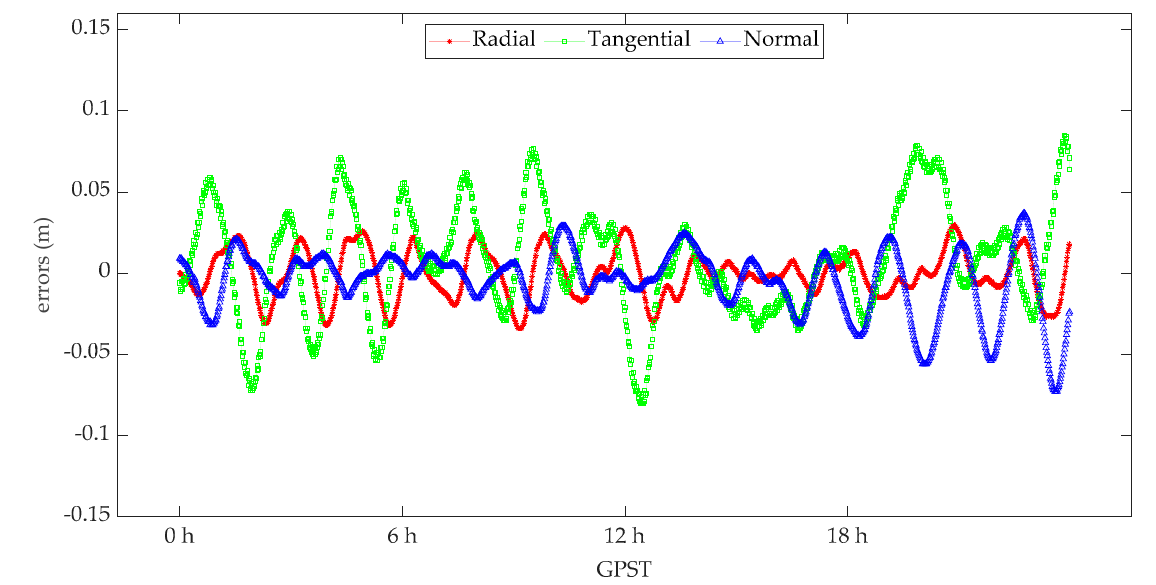
Figure 7. The variation in errors for the HY2D satellite using spaceborne GPS data compared with CNES orbit.